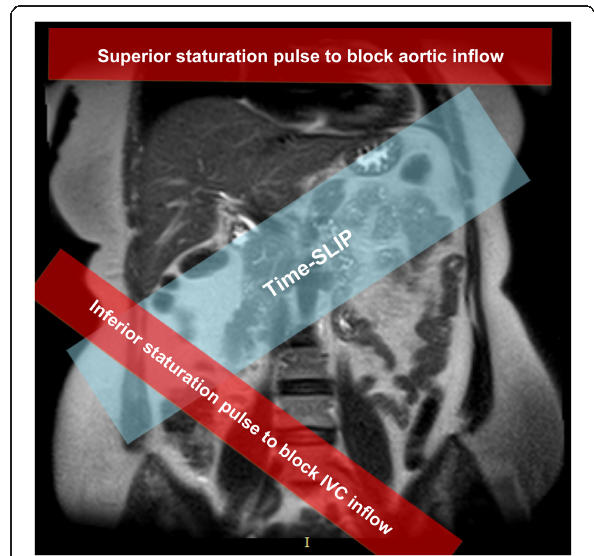
Fig. 1 Planning of non-contrast MR portography. Placement of time- spatial labeling inversion pulse (T-SLIP) parallel to inferior liver edge (blue) with additional superior and inferior saturation pulses (reds) to block aortic and IVC inflows,